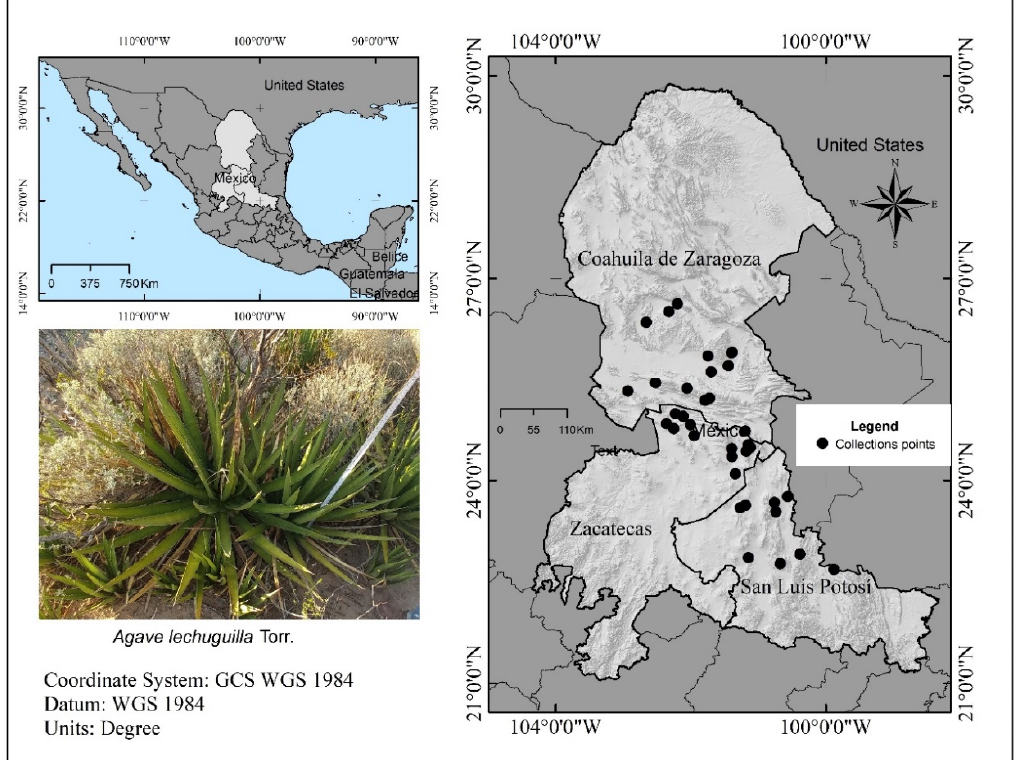
Figure 1. Location of collection points for Agave lechuguilla Torr. in Mexico.